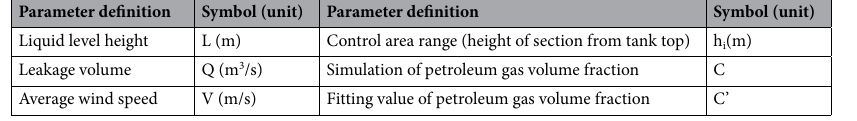
Table 3. Parameter